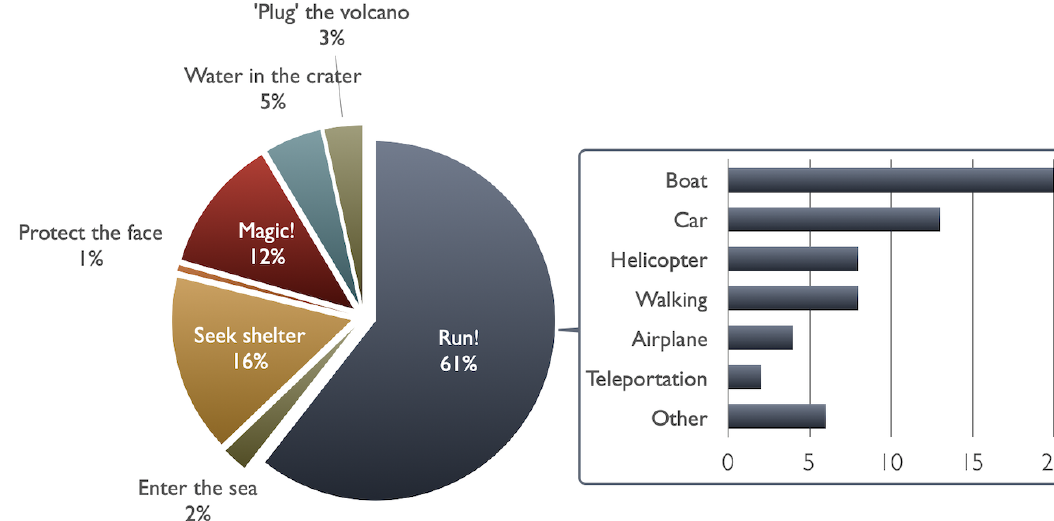
Figure 6. Characters’ actions and response to the eruption (frame 3).